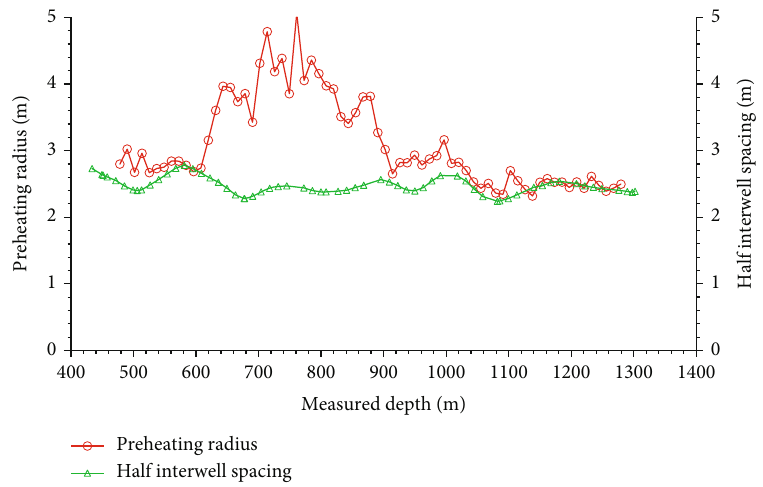
Figure 9: Comparison curve of preheating radius and half-interwell spacing along the horizontal